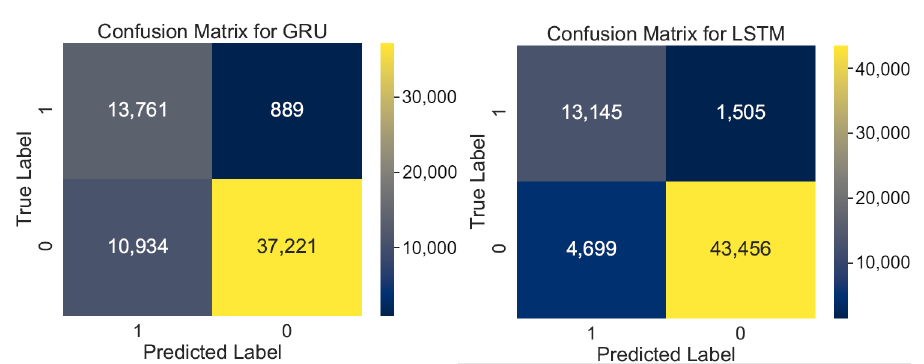
Figure 8. Confusion matrix for GRU and LSTM.